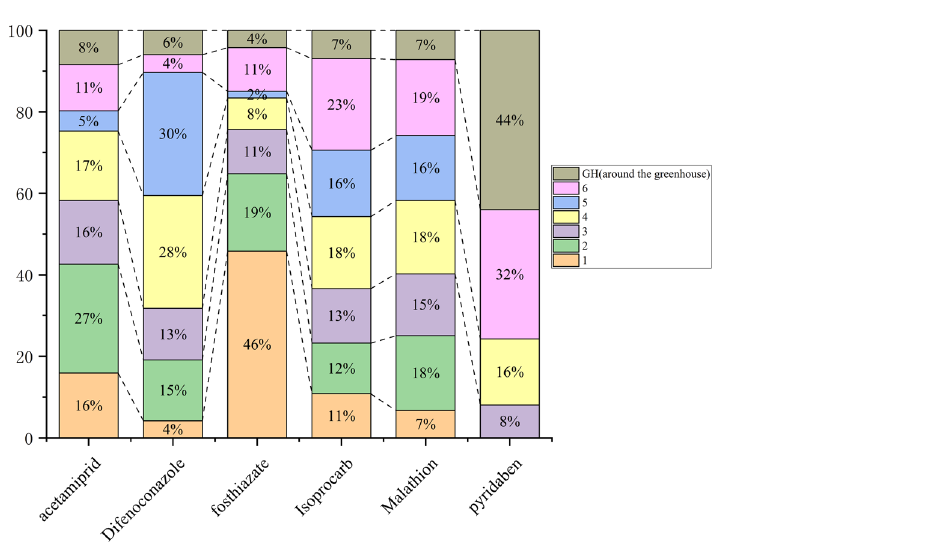
Figure 1. Average EC of 7 households in agricultural areas.